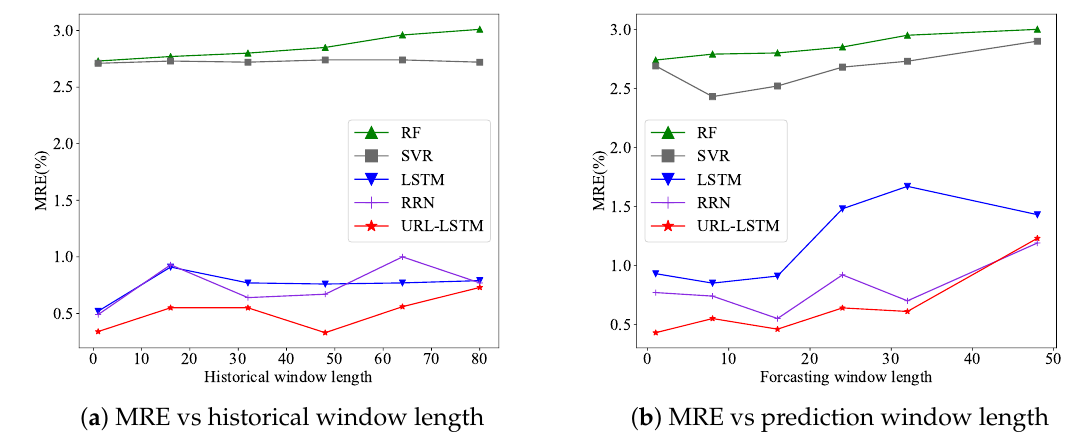
Figure 11. The analysis of parameter